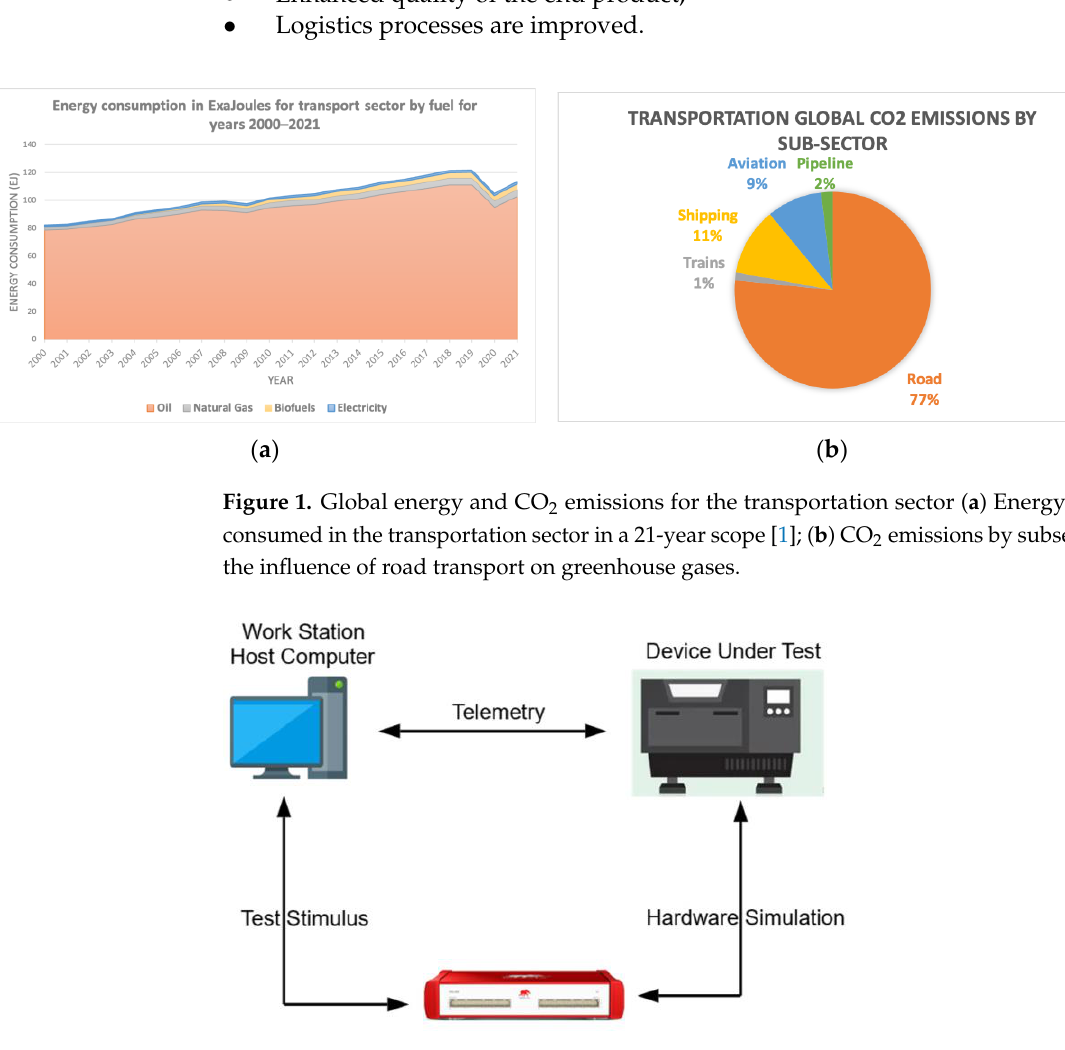
Figure 2. Implementation of the digital twin using hardware in the loop system [7]. Applying uni- fied testing both virtually and physically on the same unit provides faster error tracking and an easier understanding of the process.